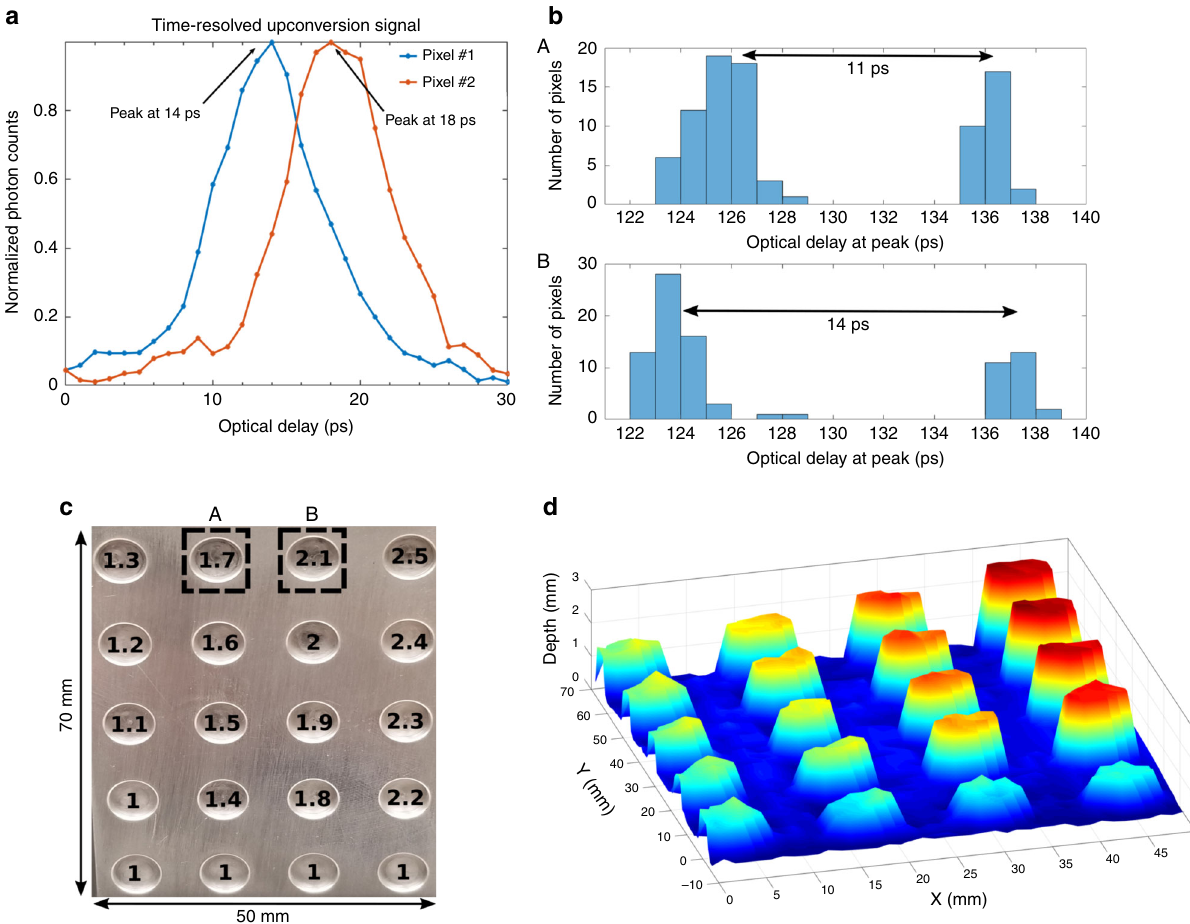
Fig. 2 High resolution single photon sensitive 3D imaging. a Time-resolving photon counting from two different longitudinal positions. b MLV histogram for two regions (A and B) within the dotted lines in ( c ). c 5 cm × 7 cm CNC machined aluminum depth resolution calibration chart. d Reconstructed image of the depth resolution chart in ( c